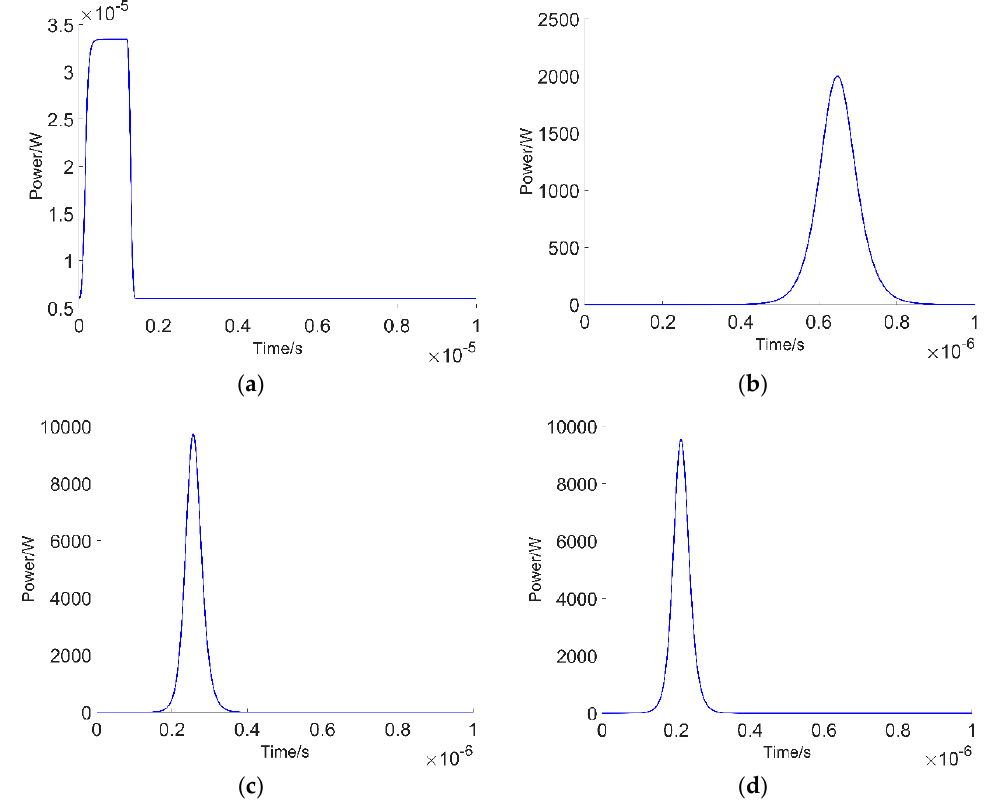
Figure 8. Numerically calculated dependence of the output power on time for a 2 (m) long fiber with the facet reflectivity for signal wave at z = L switched between 0.04 and 0.2 and T tr = 200 (ns): ( a ) At pump power of 1.2 (W); ( b ) At pump power of 1.5 (W); ( c ) At pump power of 2 (W); ( d ) At pump power of 8 (W).